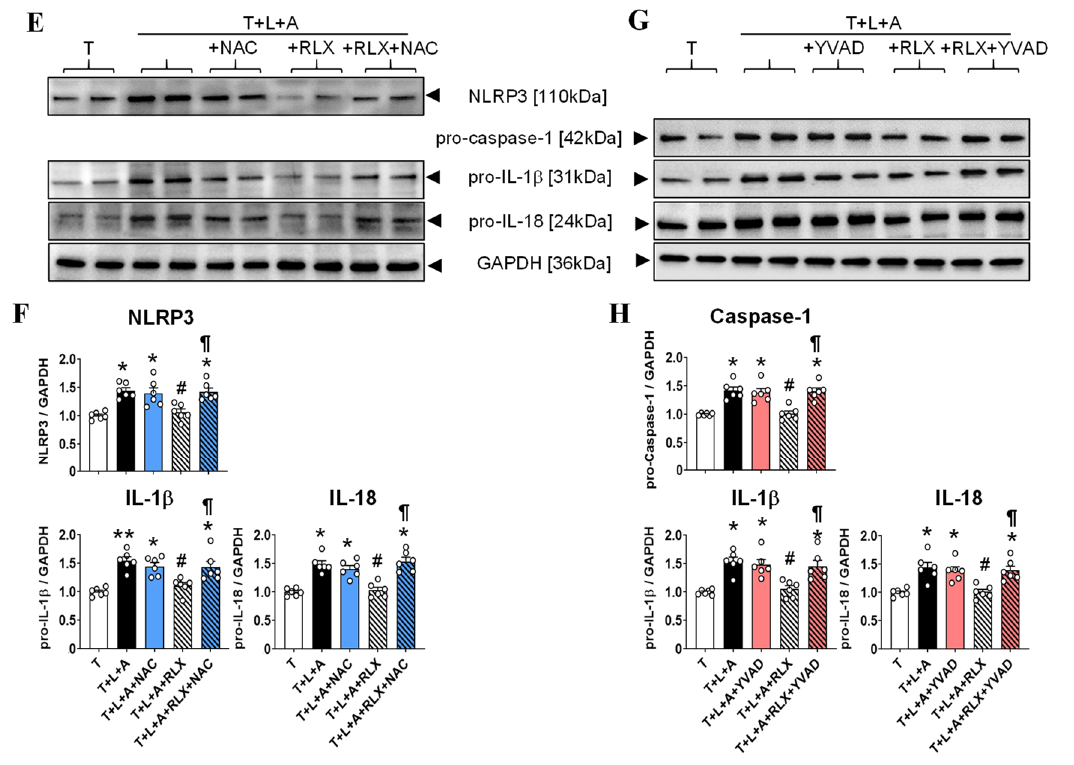
Figure 4. The effects of RLX ± the P2X7R inhibitor (A4), TLR-4 inhibitor (TAK), ROS inhibitor (NAC) and caspase-1 inhibitor (YVAD) on the T+L+A-stimulated increase in myofibroblast NLRP3 inflammasome measures. ( A , C , E , G ) Representative Western blots of TLR-4, NLRP3 (or pro-caspase-1 for the studies involving YVAD), pro-IL- β and pro-IL-8 expression from HCMFs treated with TGF- β 1 (T), T+L+A, T+L+A+A4, T+L+A+RLX or T+L+A+RLX +A4 ( A ); T, T+L+A, T+L+A+TAK, T+L+A+RLX or T+L+A+RLX +TAK ( C ); T, T+L+A, T+L+A+NAC, T+L+A+RLX or T+L+A+RLX+NAC ( E ); or T, T+L+A, T+L+A+YVAD, T+L+A+RLX or T+L+A+RLX+YVAD ( G ), after 8 h. ( B , D , F , H ) Also shown are the mean ± SEM of each end point measured from each treatment group studied, corrected for GAPDH (house-keeping protein) loading, and expressed relative to the value in the T-stimulated cell group, which was expressed as 1 in each case, from n = 6 separate experiments conducted in duplicate. The individual data sets for each group are represented by the white circles within each set of bar graphs. * p < 0.05, ** p < 0.01 compared with the T alone group; # p < 0.05 compared with the T+L+A group; ¶ p < 0.05 compared with the T+L+A+RLX